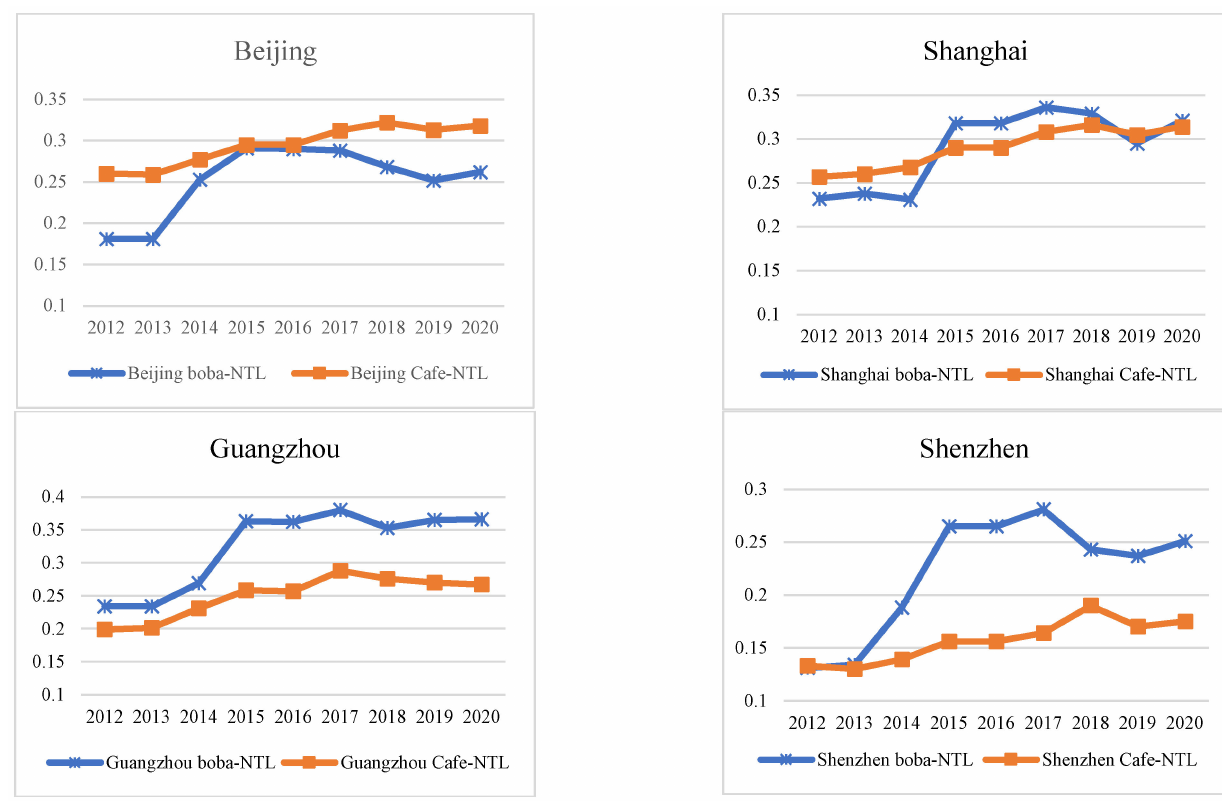
Figure 8. Global bivariate Moran’s I coefficient between boba/coffee shops and NTL intensity (urban vitality) in Beijing, Shanghai, Guangzhou,